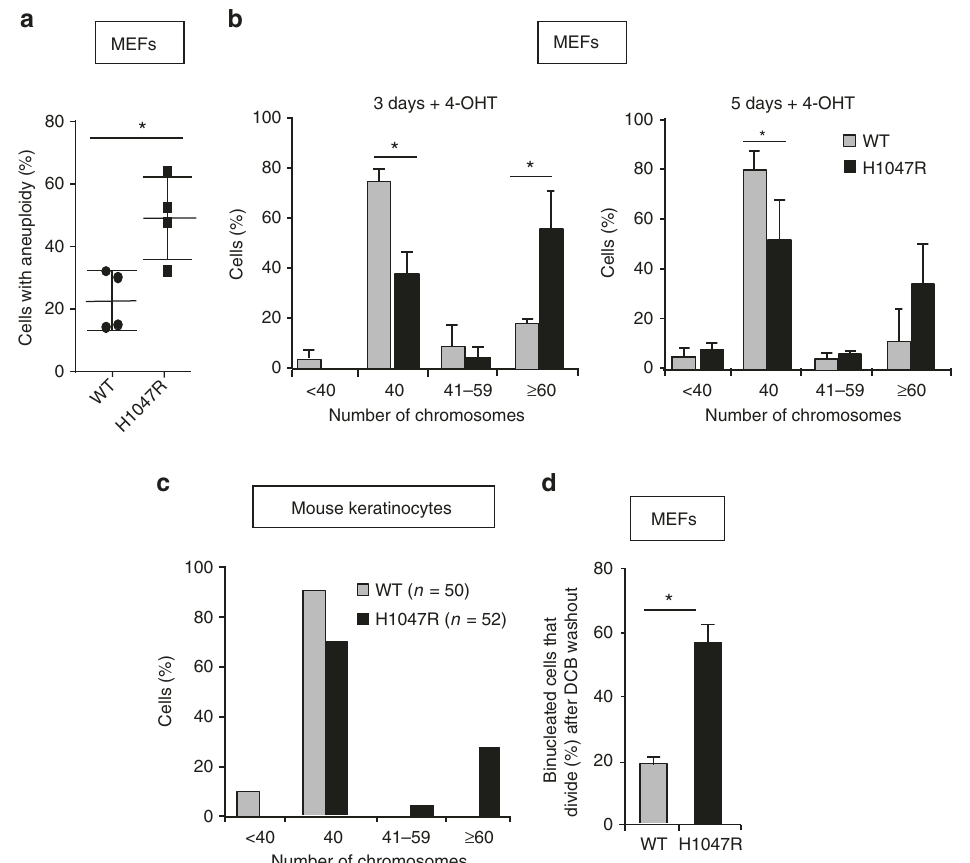
Fig. 6 p110 α H1047R expression provides cellular tolerance to genome doubling. a Frequency of aneuploid cells (i.e. with a number of chromosomes that differs from 40), assessed by metaphase chromosome spreads, in primary MEFs 5 days after treatment with 4-OHT. Statistically signi fi cant differences